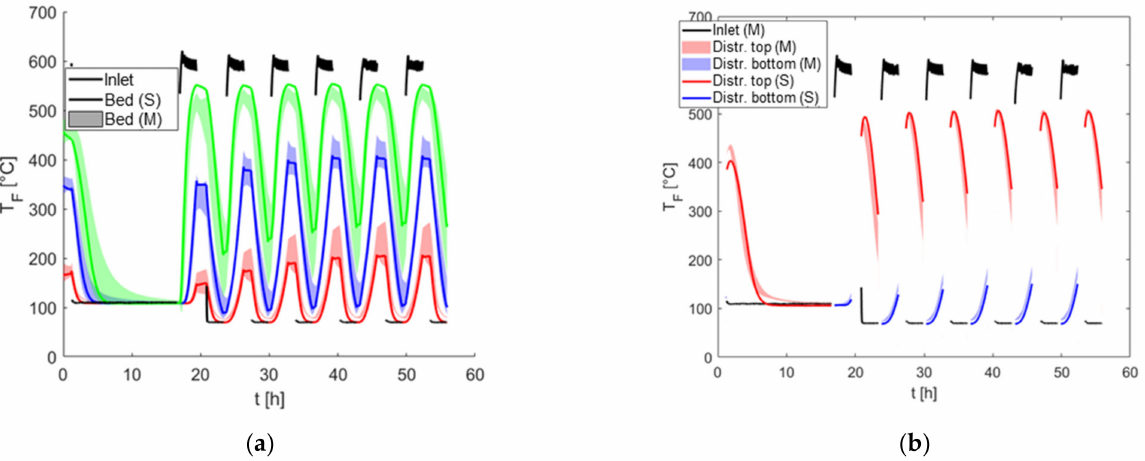
Figure 21. Test T1—Fluid temperature (TF), measurement (M), simulation (S): ( a ) temperature at bed height 0.3 m (red), 0.9 m (blue), 1.5 m (green); ( b ) temperature in the hot-side (top)/cold-side (bottom)